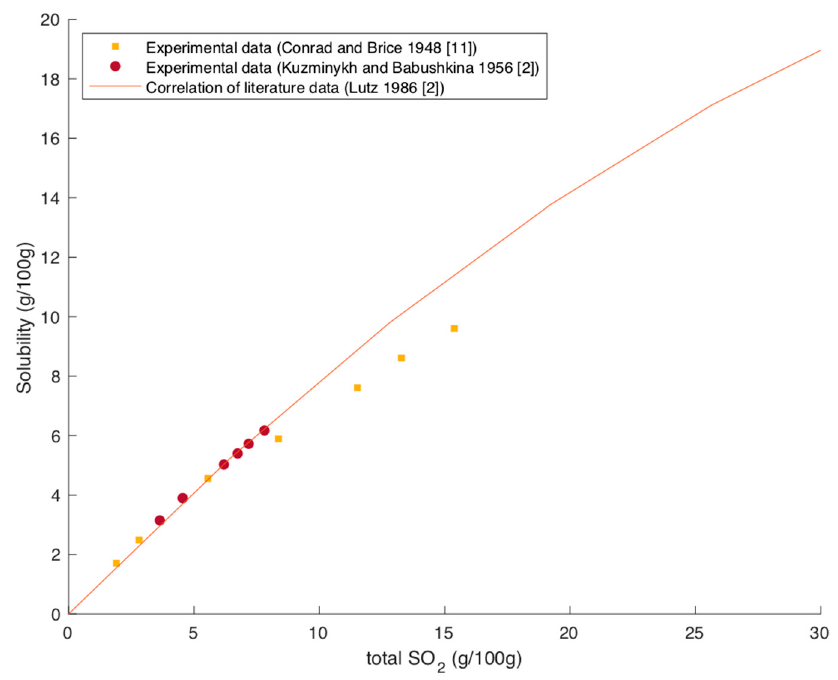
Figure 7. Solubility of CaSO 3 over total SO 2 content in the solution [2,11]. The data from Kuzminykh and Babushkina in 1956 are taken from the IUPAC solubility data series [2]. Lutz recommends describing the change in solubility with the presence molality of SO 2 in